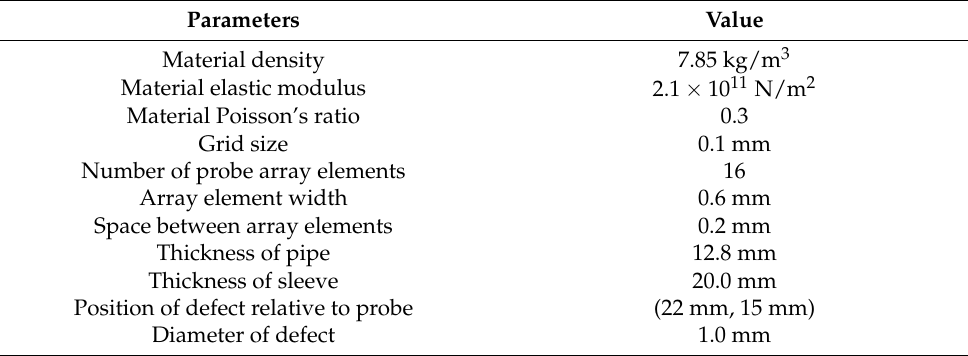
Table 2. Parameters of the simulation model.